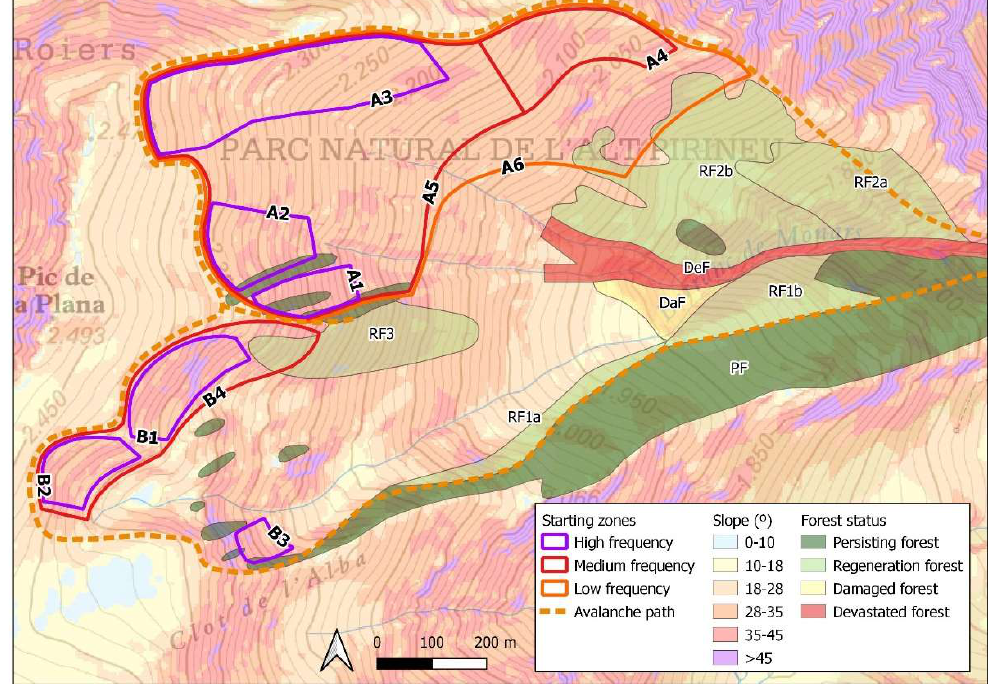
Figure 13. Starting zones of Monars avalanche path, deduced from changes on forest cover, damage observed on vegetation, dendrogeomorphological analyses, witness observations, and terrain characteristics. Polygons define probable release areas, which does not mean that all the areas would release at the same time.